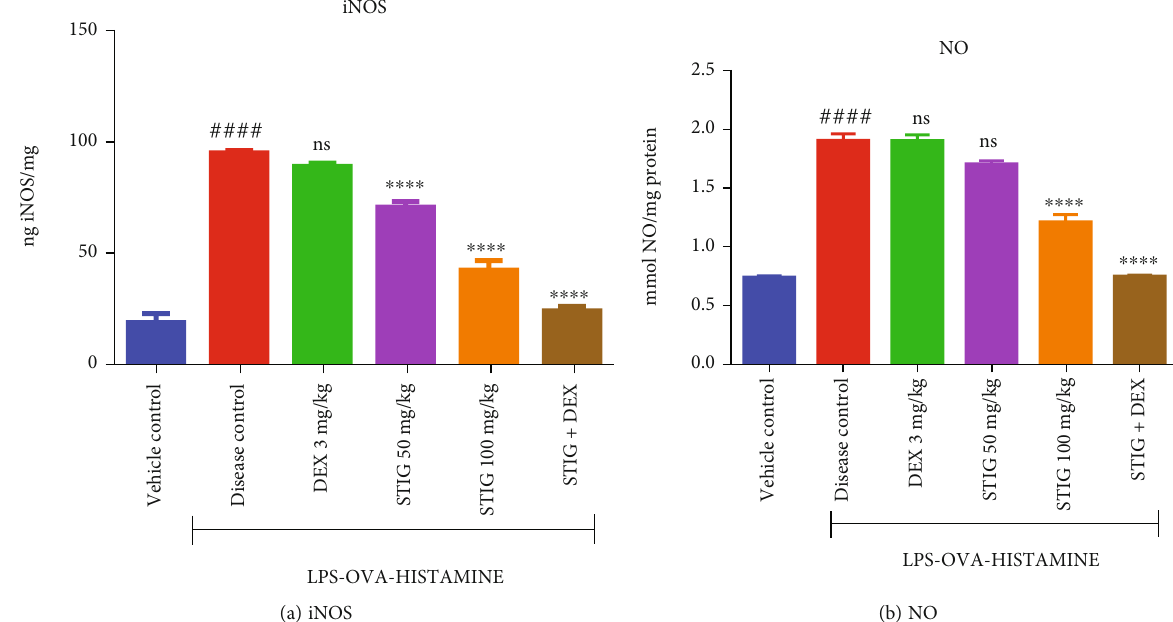
Figure 5: E ff ect of STIG and STIG+DEX on nitric oxide and inducible nitric oxide synthase levels. #### p < 0 : 0001 compared to the vehicle control group; ∗∗∗∗ p < 0 : 0001 and ns (not signi fi cant) as compared to the disease control group by one-way ANOVA and then by Dunnett ’ s post hoc test.